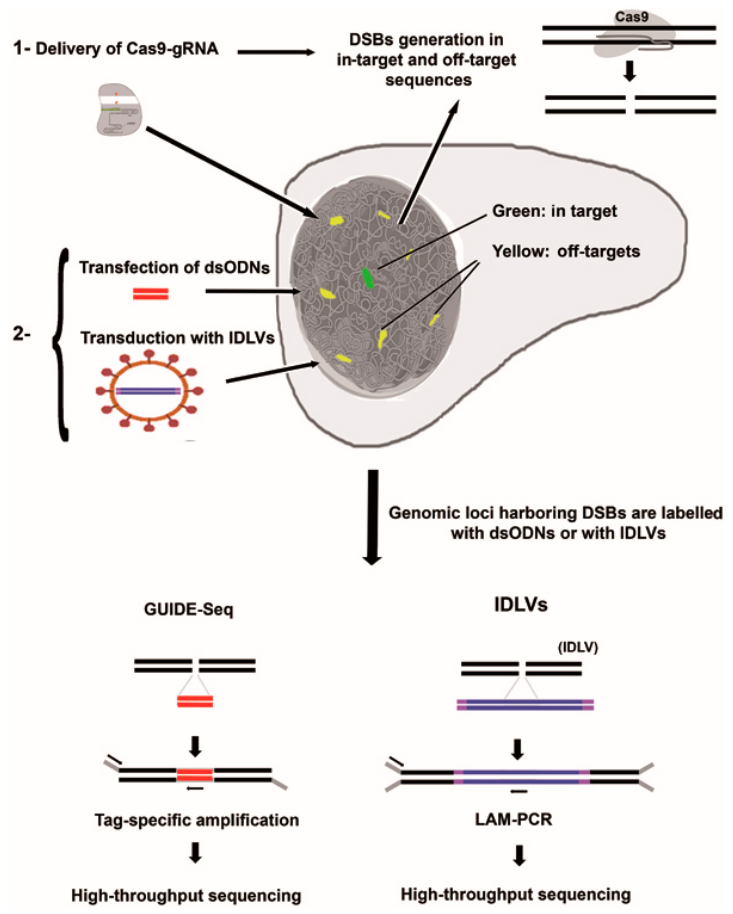
Figure 3. Unbiased methods for detection of in vivo DSBs generated by the CRSIPR/Cas9 system. Both methods consist in a tandem procedure: (1) The Cas9 and the gRNA are delivered into the target cells to induce the DSBs (top). These DSBs are generated at the in-target site (green) and at the off-target sites (yellow); (2) After 24–48 h, depending on the system used to deliver Cas9-gRNA complexes, the dsODNs (GUIDE-seq) or the IDLVs particles (IDLV-capture) are delivered. The dsODNs and the IDLVs integrate into the DSBs and label the genomic locations where the Cas9-gRNA cleaves in an unbiased manner and in real cell targets. The genomic locations are identified by tag-specific amplification (GUIDE-seq) or LAM-PCR (IDLV-capture) and high-throughput sequencing.